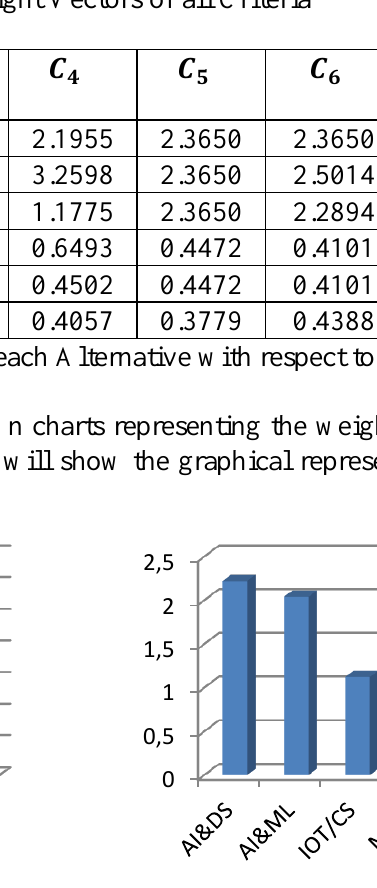
Figure 2: Weights of alternatives with respect to C